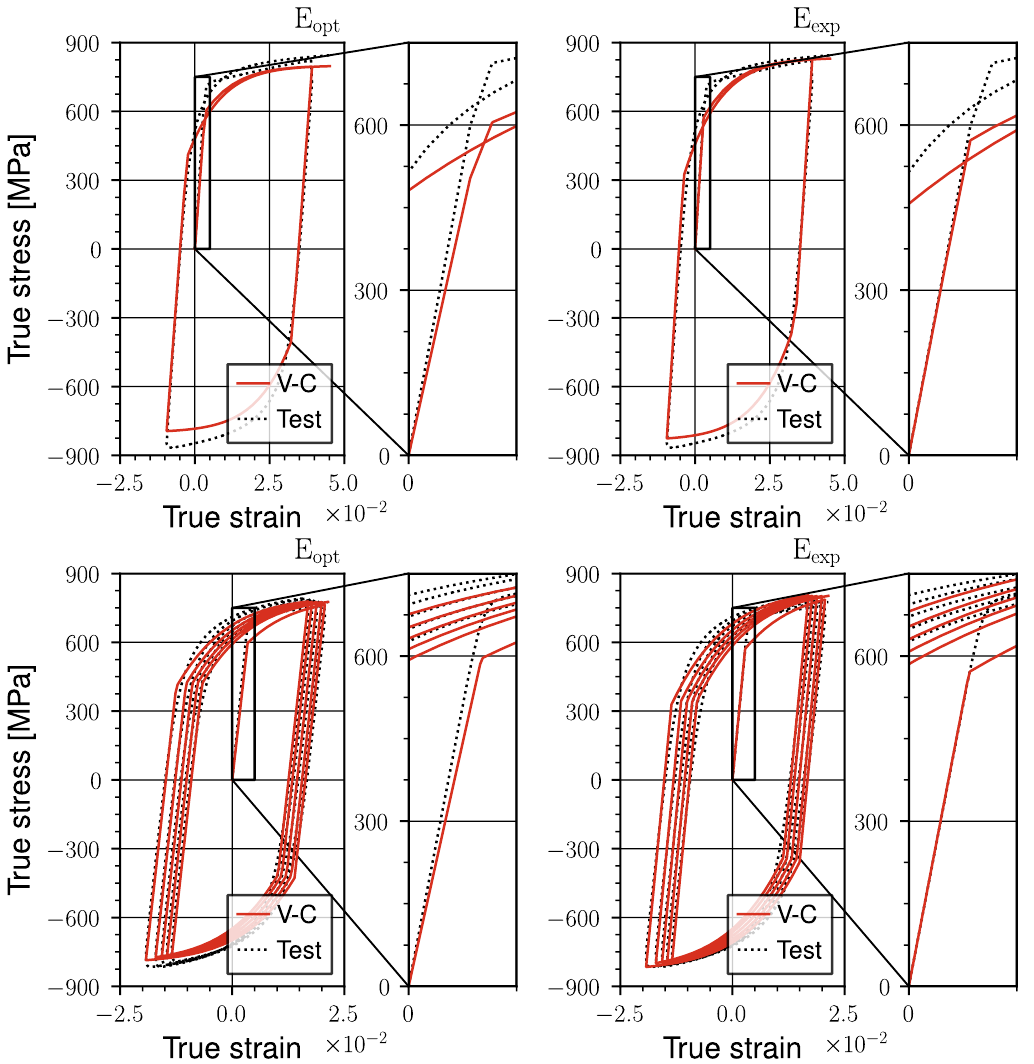
Figure 8. Selected material model parameter estimation results and the corresponding V–C model for the WM. The plots highlight the differences in the elastic material response based on the choice of elastic modulus (E opt or E exp